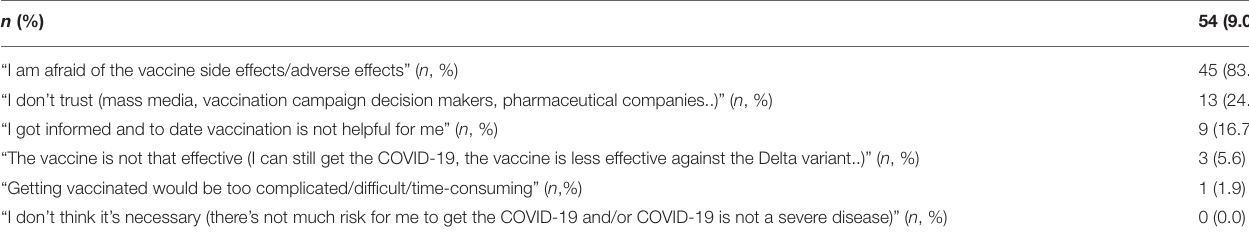
TABLE 2 | Caregivers’ reasons for refusing to be vaccinated against COVID-19. As the caregiver could express a maximum of two reasons, the cumulative percentage overcomes